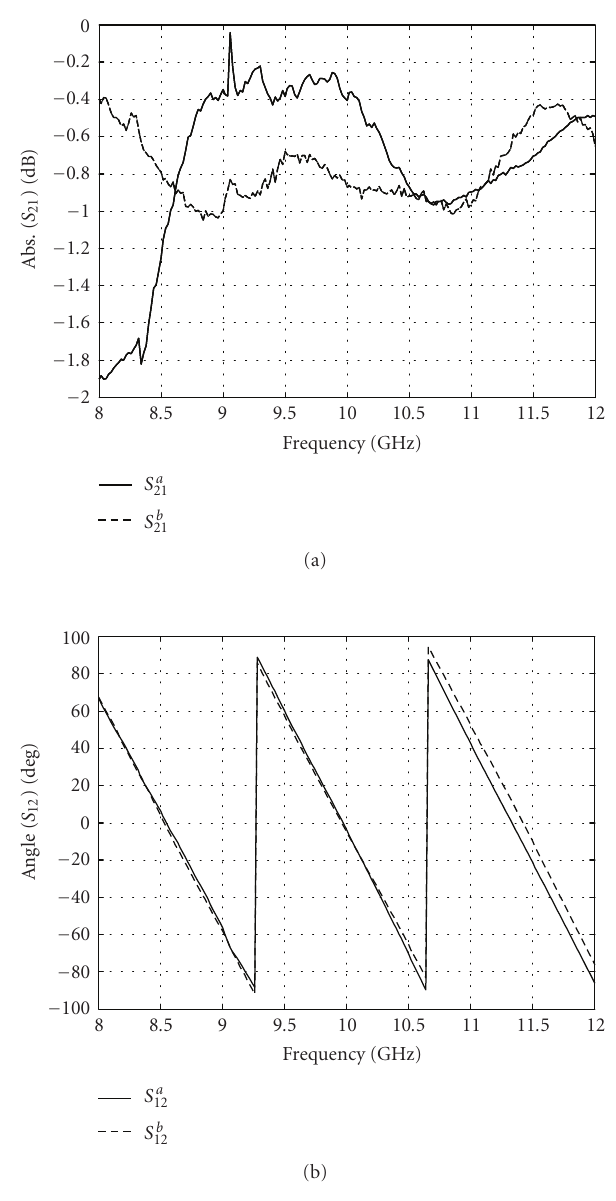
Figure 6: S a 12 and S b 12 used for compensation of measurements.